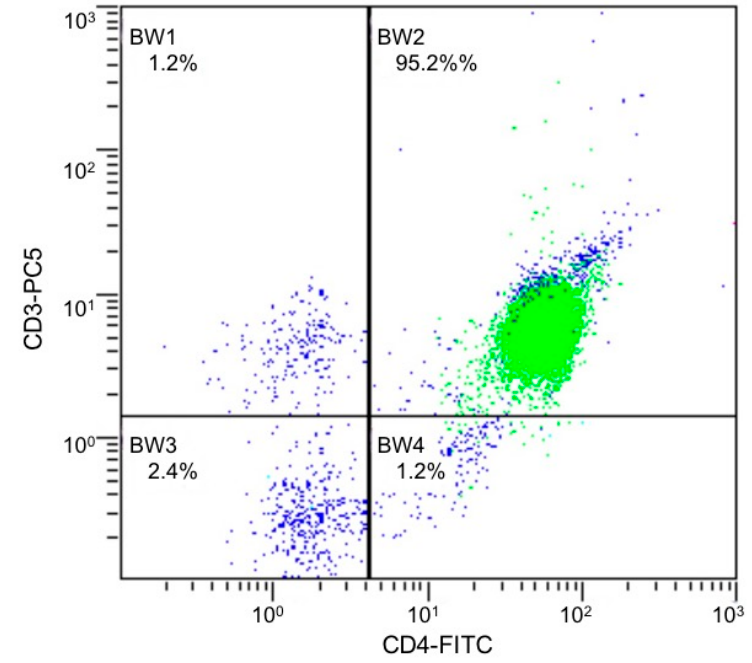
Figure 2. Flow cytometry graph of CD4+ T cells isolated from PBMCs from a representative patient. CD4+/CD3+ represent 95.2%. FICT, fluorescein isothiocyanate; PC5, phycoerythrin-cyanine5. In green, gate of lymphocytes; in blue, total cells.